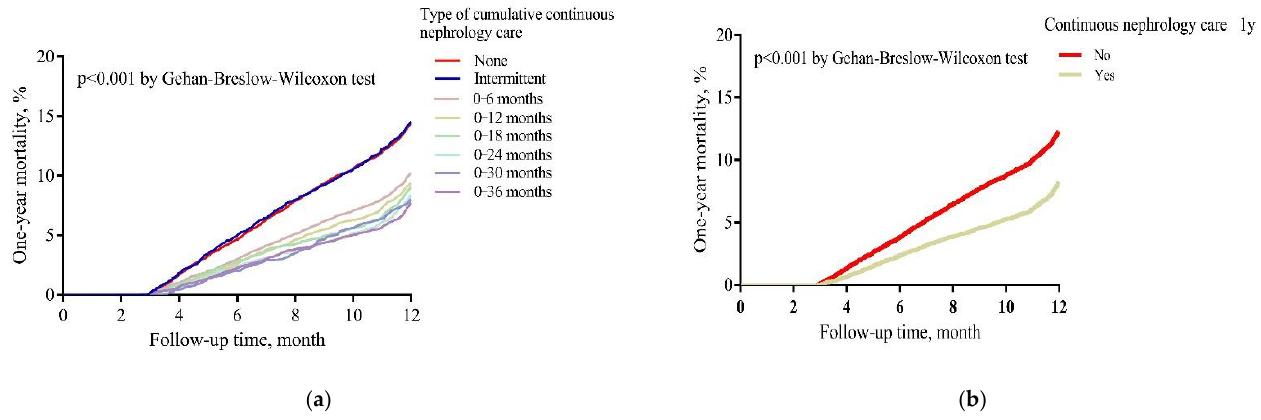
Figure 3. Cumulative mortality proportion between ( a ) ≥1 year vs. <1 year nephrology care; ( b ) types of cumulative nephrology care. The time was calculated from the date of dialysis initiation to the date of death, or the end date of the first year, whichever came first. Cumulative one-year mortality proportions were estimated by the Kaplan Meier approach and assessed the differences between groups by Gehan–Breslow–Wilcoxon test.p<0.001.